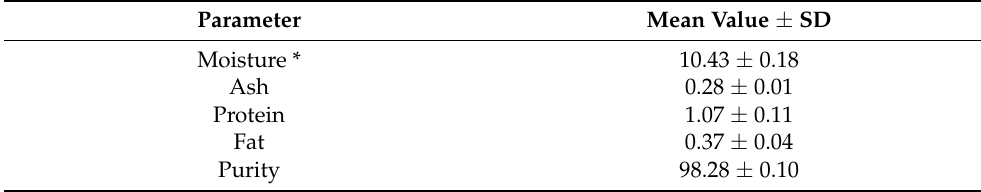
Table 6. Proximate analysis of Ceiba aesculifolia subsp. parvifolia tuber starch